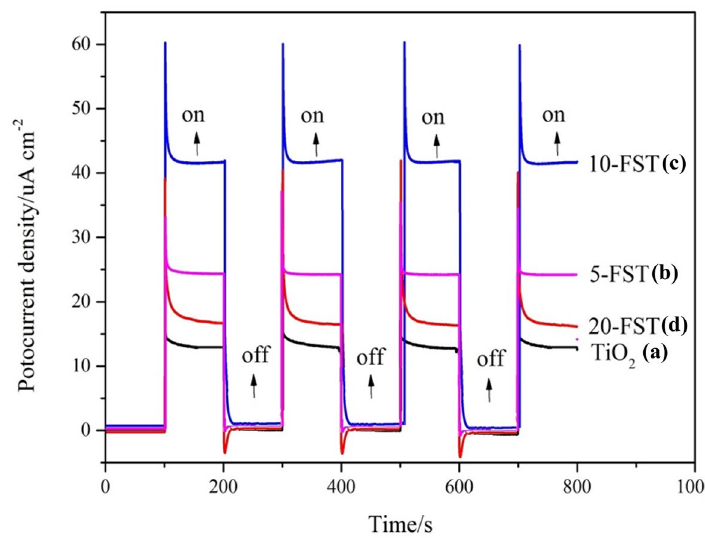
Figure 3. Photocurrent density time curve of TiO 2 ( a ), 5-FST ( b ), 10-FST ( c ), 20-FST ( d